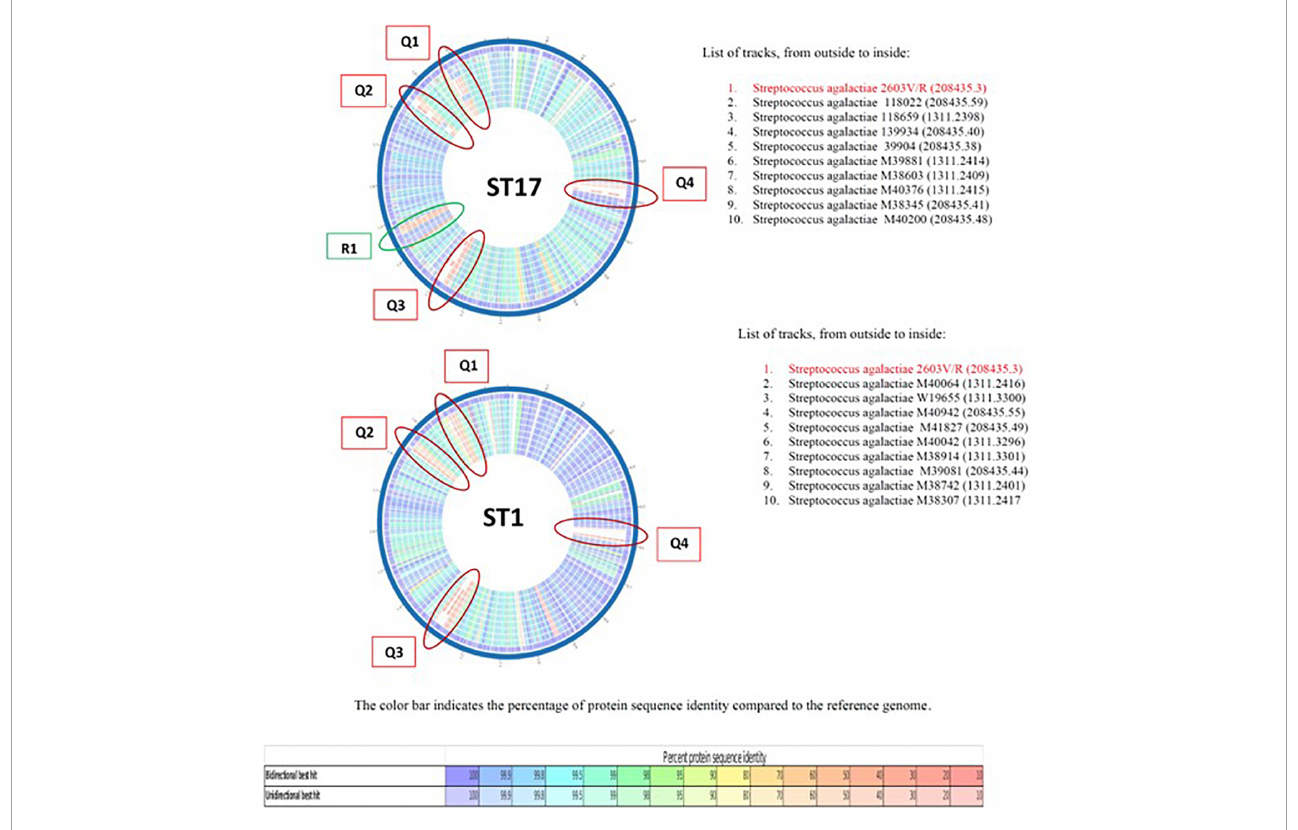
FIGURE3 The comparison of representative nine ST17 and nine ST1 strains relative to a reference group B streptococcus (GBS) genome S. agalactiae 2603 V/R (ATCC BAA611). Colored vs. white highlights insertions/deletions. Changes in conservation relative to the reference genome (going from blue representing the highest protein sequence similarity to red representing the lowest). Each circle represents the genome of GBS